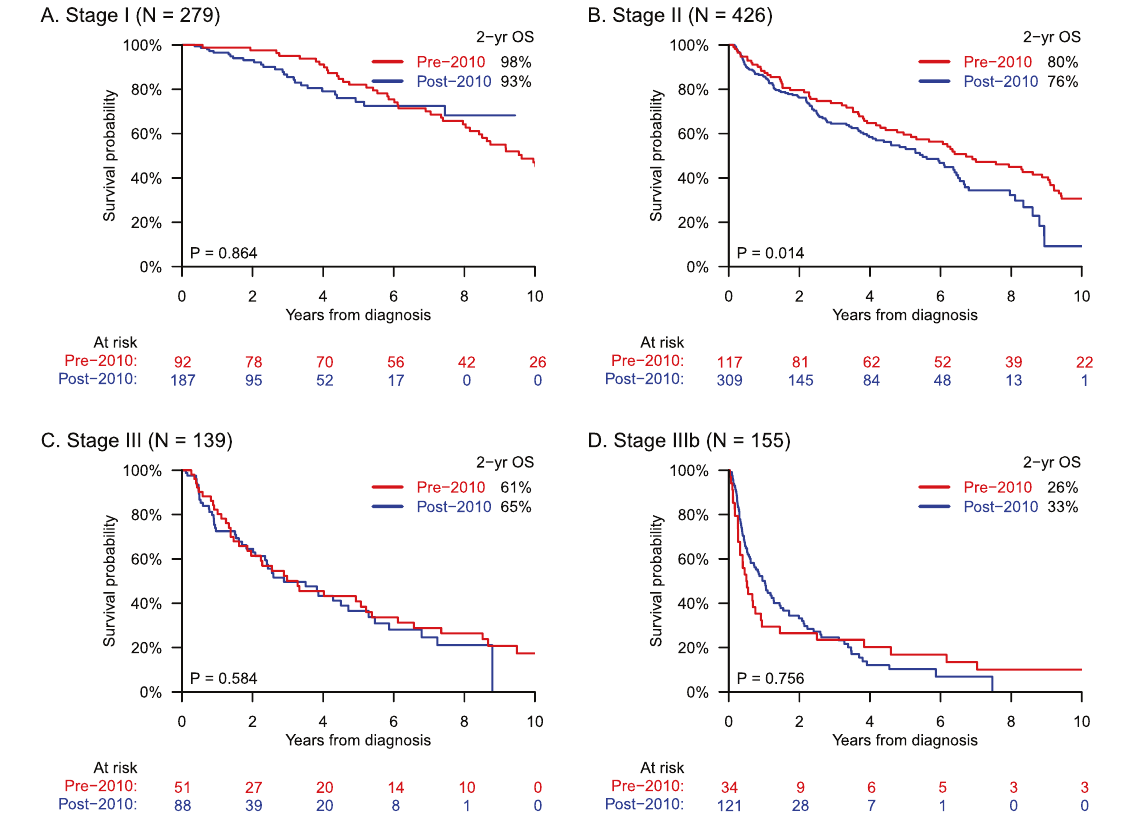
Fig. 2 Survival according to BNP-based cardiac stage before and after 2010. Despite the introduction of bortezomib-based regimens in 2010, survival did not improve signi fi cantly for any cardiac stage I – IIIb, as shown in panels ( A – D ), respectively. Complete biomarker data sets (BNP and troponin-I) were not available until 2007. Accordingly, pre-2010 and post-2010 consisted of patients diagnosed in 2007 – 2009 and 2010 – 2019, respectively. The apparent decline in survival for cardiac stage II disease ( B ) may be the result of censorship bias due to shorter follow-up for the post-2010